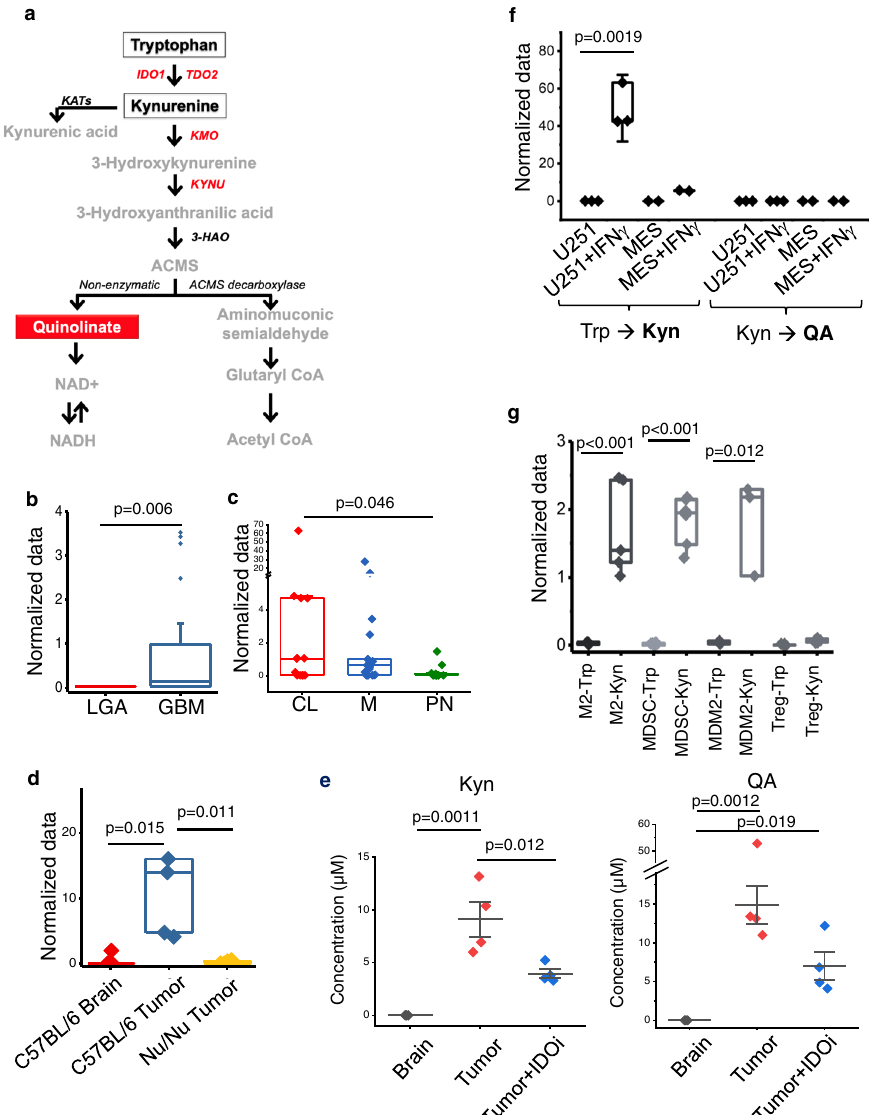
Fig. 1 | Quinolinate (QA) accumulation in glioblastoma (GBM). a Schematic of tryptophan (Trp) metabolism. b Metabolomic pro fi ling performed on patient- derived low-grade astrocytoma (LGA; n =28; red) and GBM ( n =80; blue) demon- strates differential accumulation of QA in GBM. All samples were biologically independent. c The relative accumulation of QA was evaluated in molecular sub- types of GBM ( n =46), classi fi ed as classical (CL, n =13; red), mesenchymal (M, n =21;blue),orproneural(PN, n =12;green).Yaxiswasabridgedat4. d Themurine GBM line TRP was grown orthotopically in C57BL/6 mice ( n =5; blue) and Nu/Nu mice ( n =6; yellow) and analyzed for QA and compared to normal murine brain ( n =5; red). All samples were biologically independent. e QA and kynurenine (Kyn) were quanti fi ed in normal brain (gray) and TRP tumors grown orthotopically in C57BL/6 mice with (blue) and without (red) the IDO inhibitor (IDOi) GDC-0919